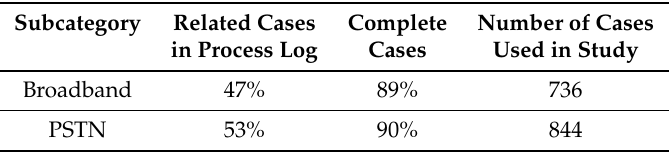
Table 1. Summary of the Customer Diagnostic Process